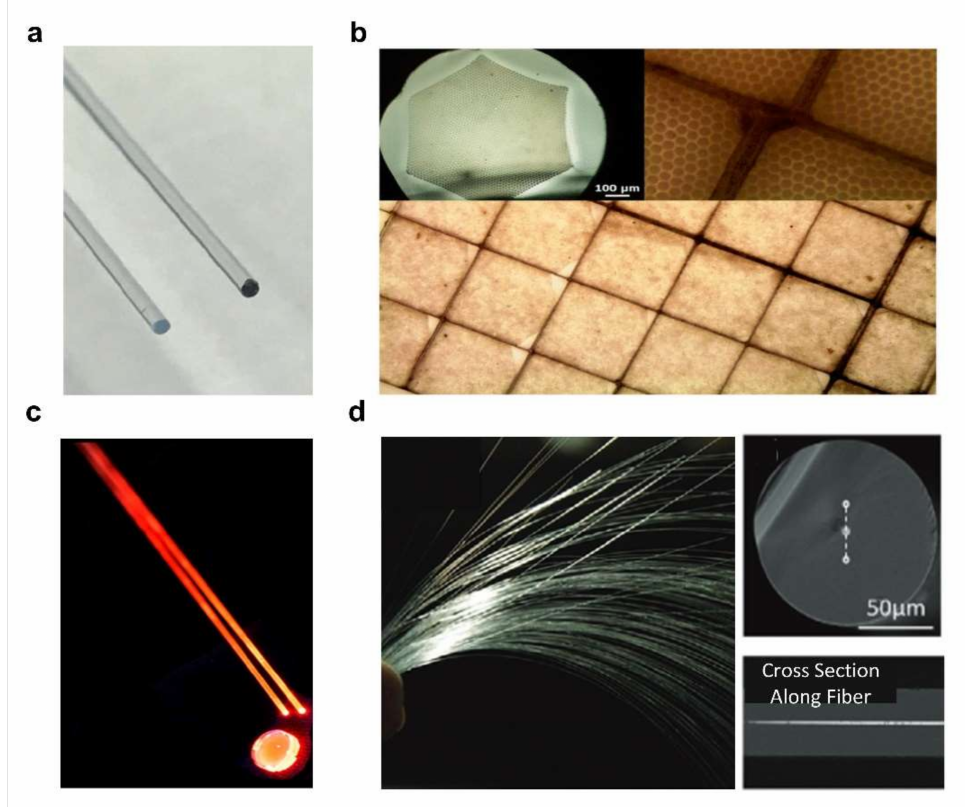
Figure 8. All-fiber radiation sensors. ( a ) 0.05% Ce-doped optical fibers before (on the left) and after 1 kGy irradiation (on the right). Reprinted with permissions from ref. [101]. Copyright 2018, Optical Society of America. ( b ) The cross-section of a Li-glass multicore fiber, and the polished faceplate surface of a multicore array. Reprinted with permissions from ref. [100]. Copyright 2019, IEEE. ( c ) Pr- doped silica scintillating fibers and faceplate. Reprinted with permissions from ref. [70]. Copyright 2017, Elsevier B.V. ( d ) LYSO:Ce core silica cladding scintillating fibers. Reprinted with permissions from ref. [102]. Copyright 2020, WILEY-VCH Verlag GmbH & Co. KGaA, Weinheim,